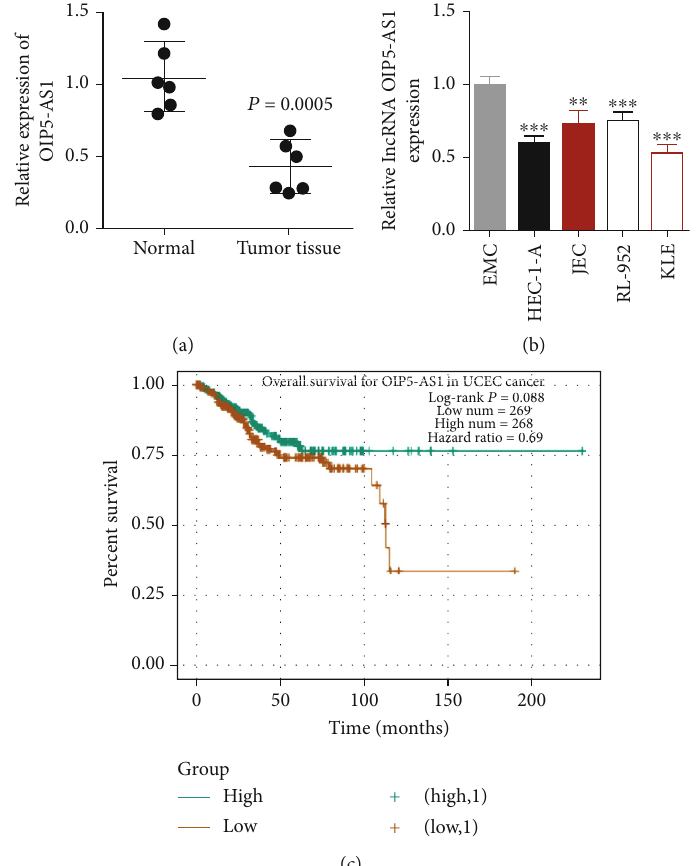
Figure 1: lncRNA OIP5-AS1 was poorly expressed in EC cells. (a) Relative expression of OIP5-AS1 in normal tissue and EC tissue from 8 patients. (b) The expression of OIP5-AS1 was signi fi cantly reduced in four EC cells compared with normal endometrial cells (ESC) by qRT-PCR. U6 was identi fi ed as an internal control. ∗∗ P < 0 : 01 and ∗∗∗ P < 0 : 001 . (c) Result of the Kaplan-Meier method analysis manifested that the high expression group had longer overall survival in contrast to the high expression group. The data source was available from the online database starBase and